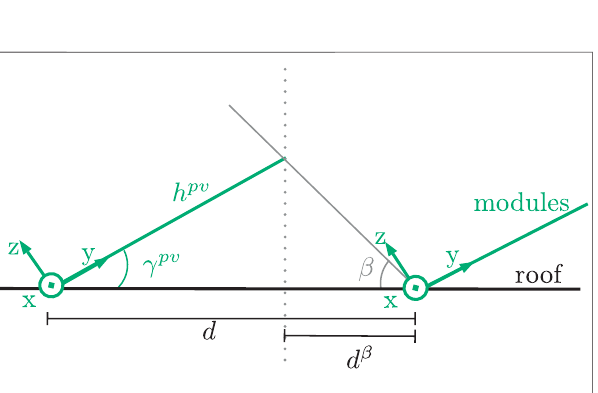
FIGURE4| Distance d betweentwomodules(green)foragivenmodule height h pv , tilt angle c pv and sun elevation/liming angle β .